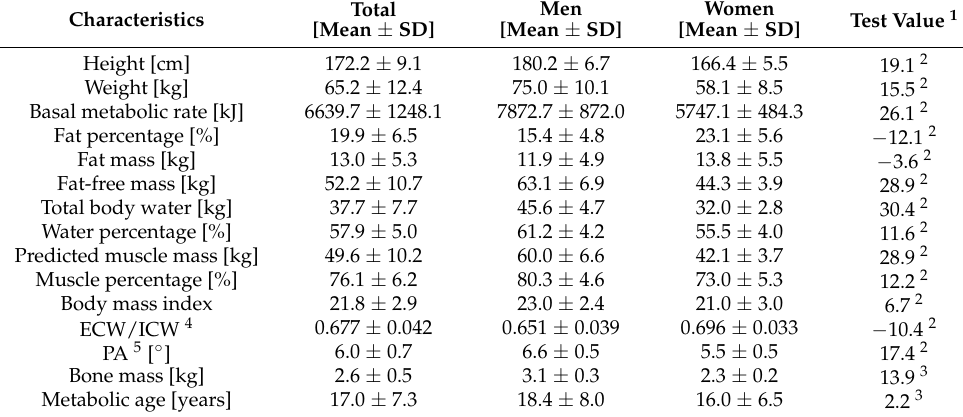
Table 2. Statistically significant differences in anthropometric and body composition parameters of the studied group depending on